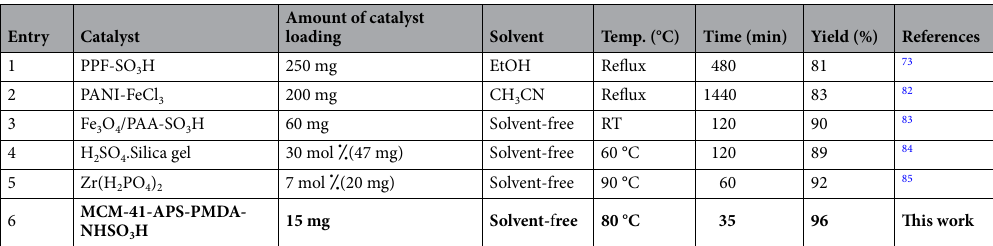
Amount of catalyst Entry Catalyst loading Solvent Temp. (°C) Time (min) Yield (%)